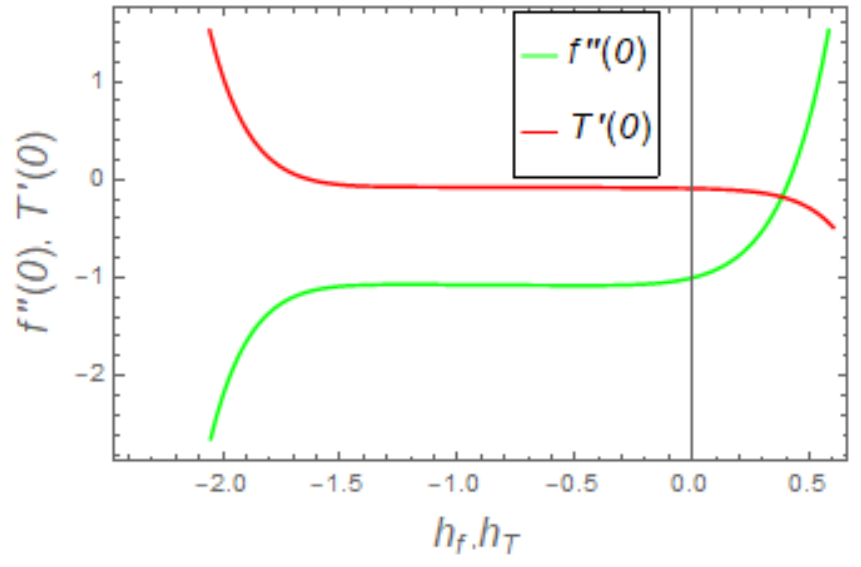
( ) ( ) f ξ T ξ and functions.